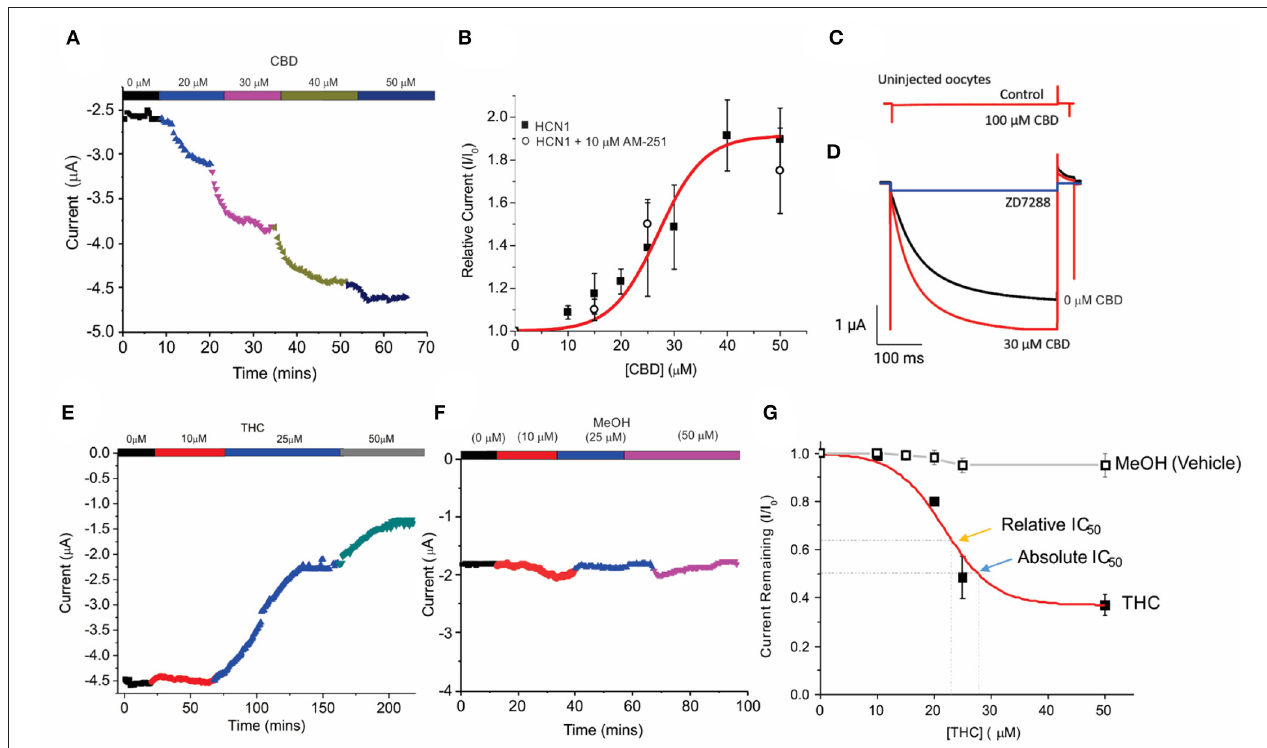
FIGURE 2 | Concentration-dependent regulation of HCN1 current by THC and CBD. (A) Steady-state current values from a representative cell following repetitive pulses to − 130mV from V H = 0mV with the addition of 0, 10, 20, 30, and 50 µ M CBD. (B) Concentration dependence of HCN1 activation by CBD ( (cid:4) ) at − 130mV ( n = 13). This activation of HCN1 persists in the presence of the CB1R antagonist 10 µ M AM-251 ( ◦ ) ( n = 5). A total of 50% Max response (EC 50 ) for CBD is elicited at 28.5 µ M, with a 91% maximal increase in current. (C) CBD has no effects on uninjected oocytes, indicating that we are not observing effects on background currents. (D) CBD activated currents can be fully inhibited by 500 µ M ZD7288. This indicates that CBD is only activating HCN1 currents, and not activating a background current in oocytes. (E) Steady-state currents from a representative cell following repetitive pulses to − 130mV in 0, 10, 25, and 50 µ M THC. (F) Steady-state currents from a representative cell following repetitive pulses to − 130mV in the presence of the quantity of methanol used as a vehicle for 0, 10, 25, and 50 µ M CBD/THC. (G) Concentration dependence of HCN1 inhibition by THC ( (cid:4) ) or methanol ( (cid:3) ) at − 130mV ( n = 5). THC induces a 63% maximal block of HCN1 currents, with a half-maximal response (Relative IC 50 ) of 21.8 µ M. 50% block of total current (Absolute IC 50 ) occurs at 28.9 µ M. Methanol induces < a 5% decrease in current at concentrations above 20 µ M ( n = 4). different compared with THC (e.g., P < 0.05 for V 1 / 2 of 30 µ